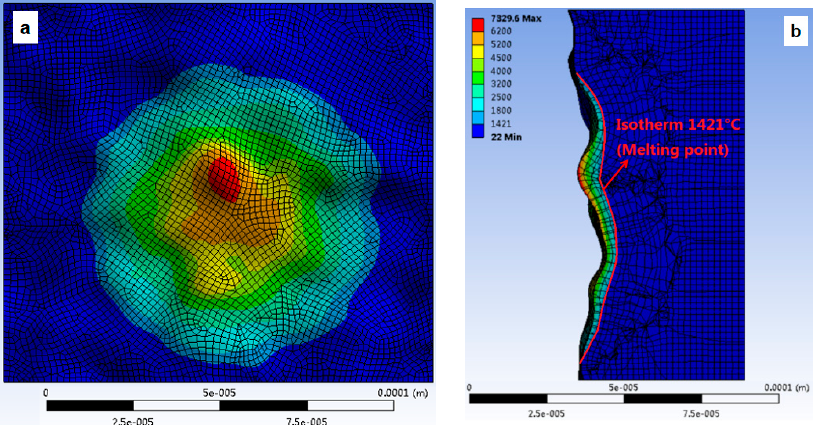
Figure 8. Numerical simulation of crater volume. Single discharge on a rough surface, as produced by WEDM roughing cut: ( a ) Front view ( b ) lateral view.